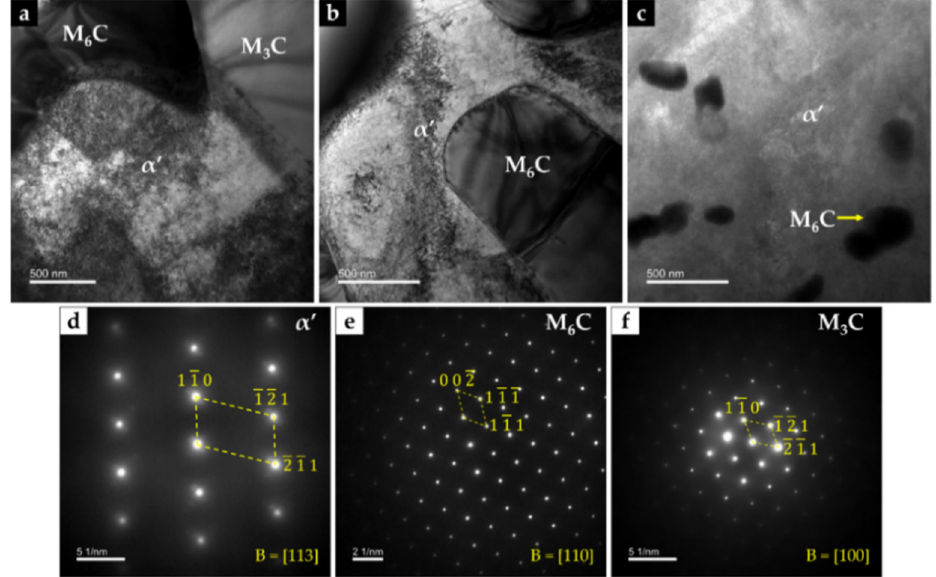
Figure 17. Dark-field TEM image of CZ1 composite zone: ( a ) interface between (Fe,W,Cr) 6 C, (Fe,W,Cr) 3 C, and α ’, ( b ) (Fe,W,Cr) 6 C with a quasi-cuboid shape precipitated within α ’ matrix, and ( c ) fine precipitates of (Fe,W,Cr) 6 C. SAED patterns were achieved by using the ( d ) [113] zone axis for α ’, ( e ) [110] zone axis for (Fe,W,Cr) 6 C, and ( f ) [100] zone axis for (Fe,W,Cr) 3 C.